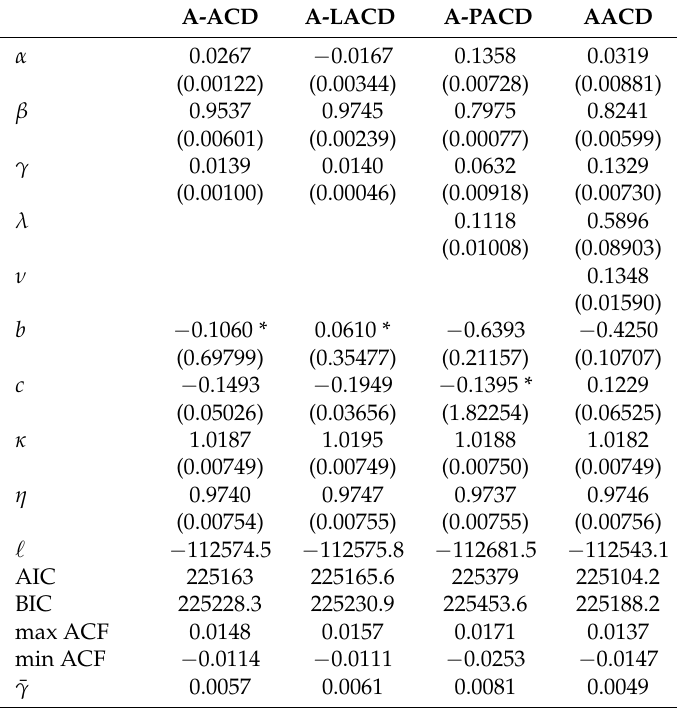
Table 8. Estimation results for ACD specifications of JNJ trade durations. A star ( parameter estimate is not significantly different from